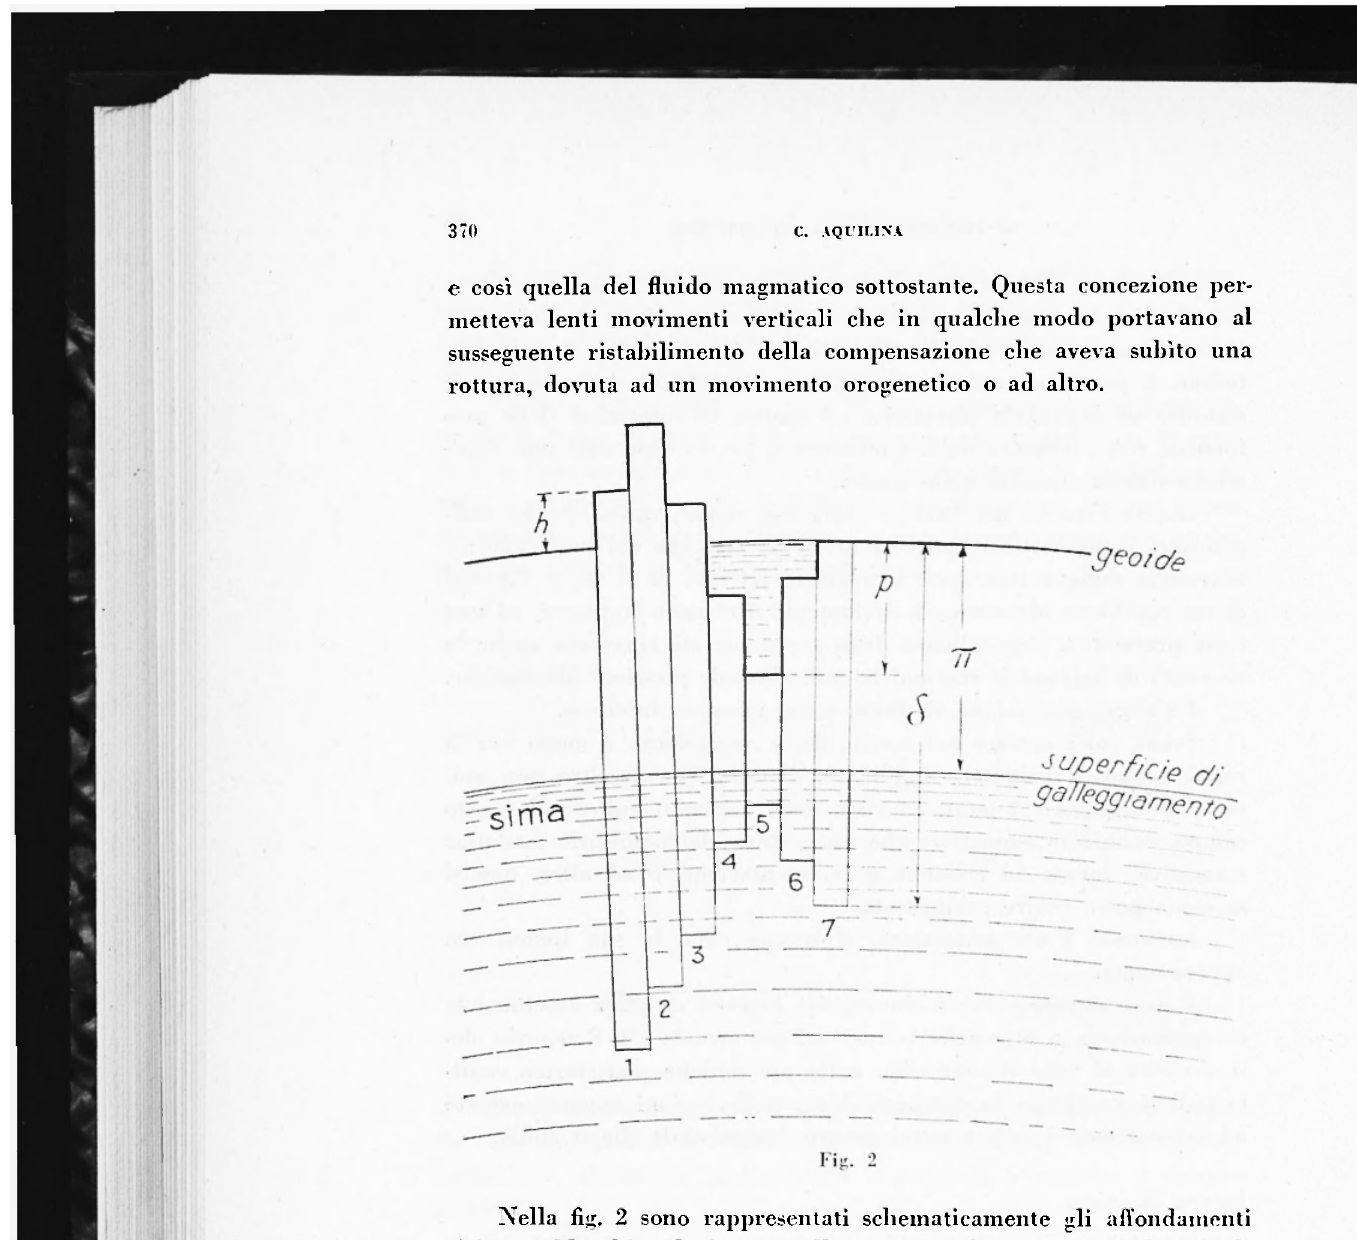
Nella fig. 2 sono rappresentati schematicamente gli affondamenti dei vari blocchi nel sima